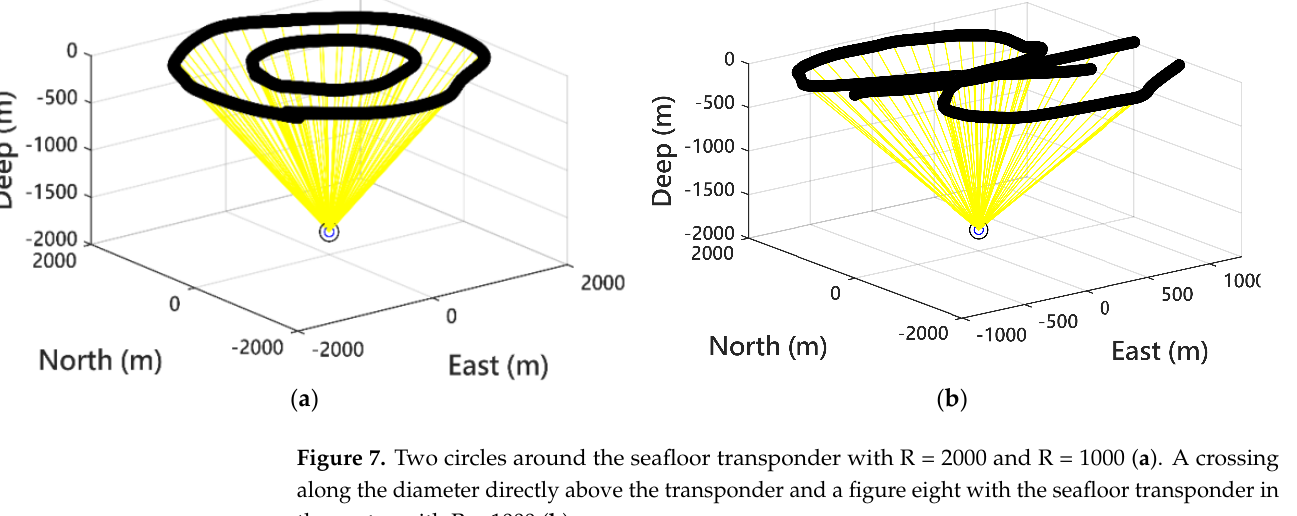
Table 1. The information of acoustic measurements.